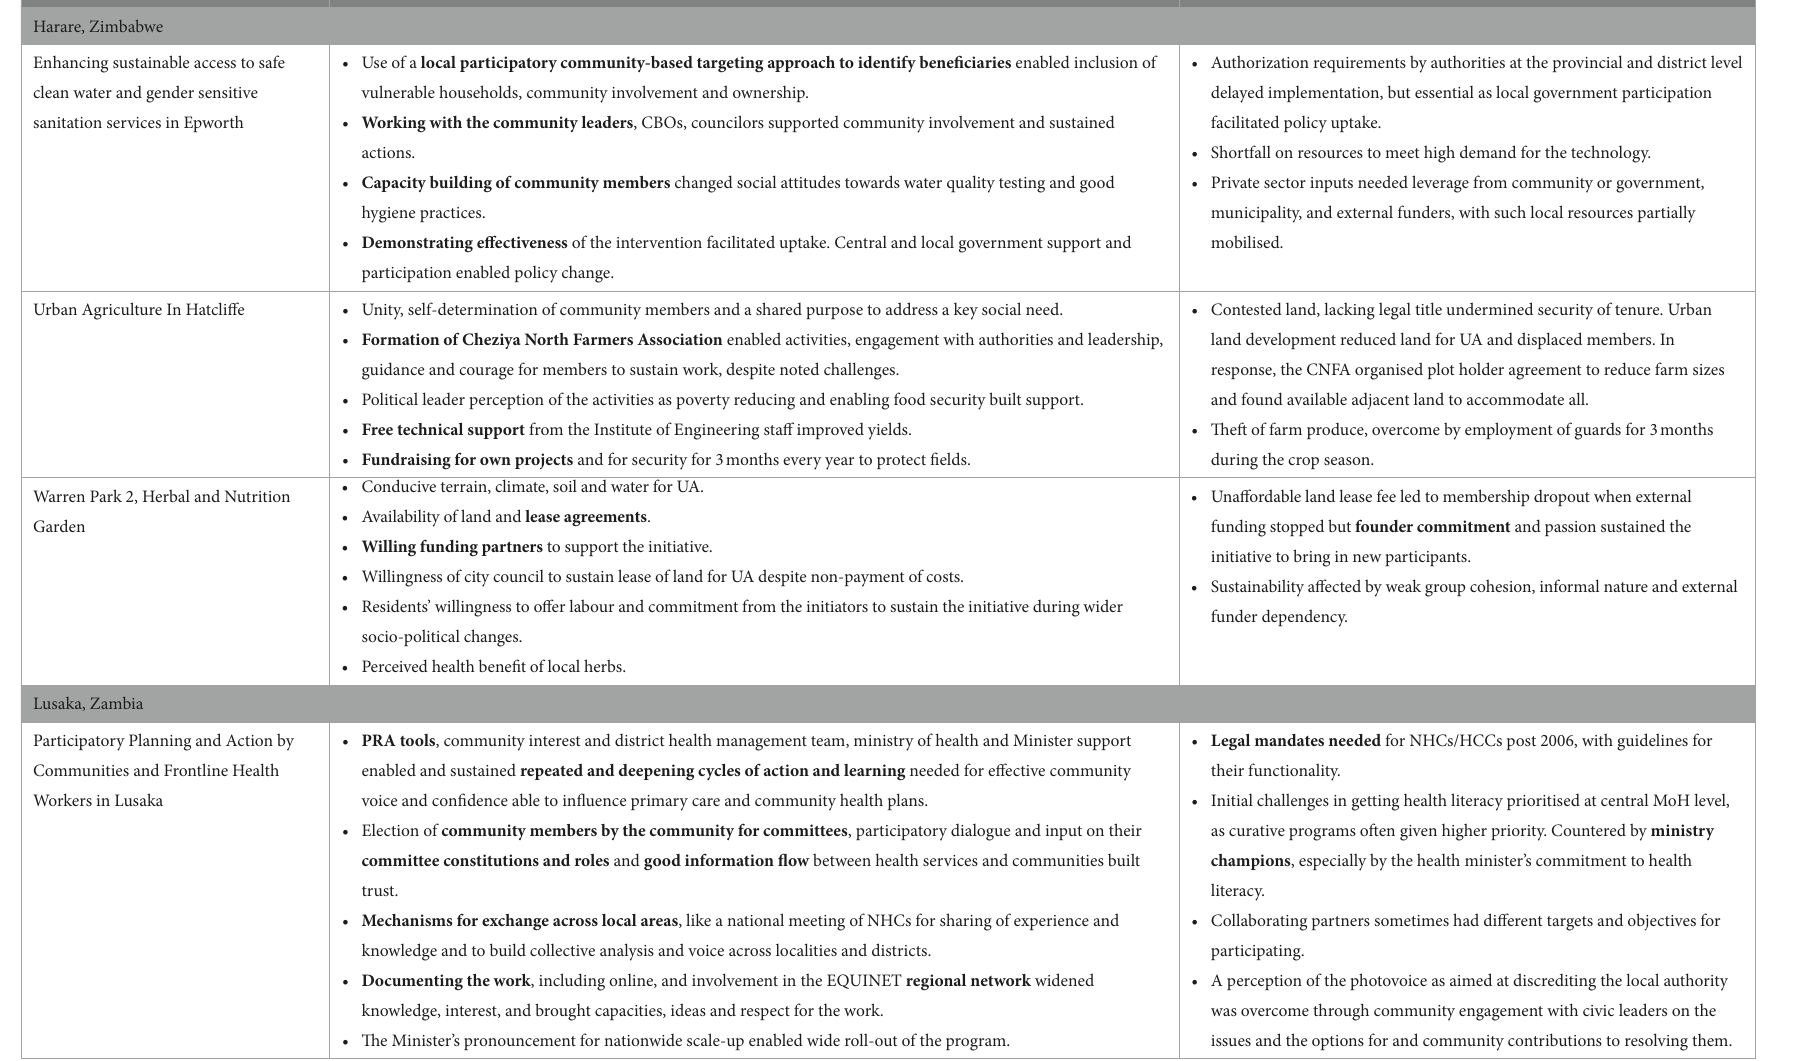
TABLE 3 Enablers and barriers in the 10 case study initiatives (key measures shown in bold). Initiative Key enablers